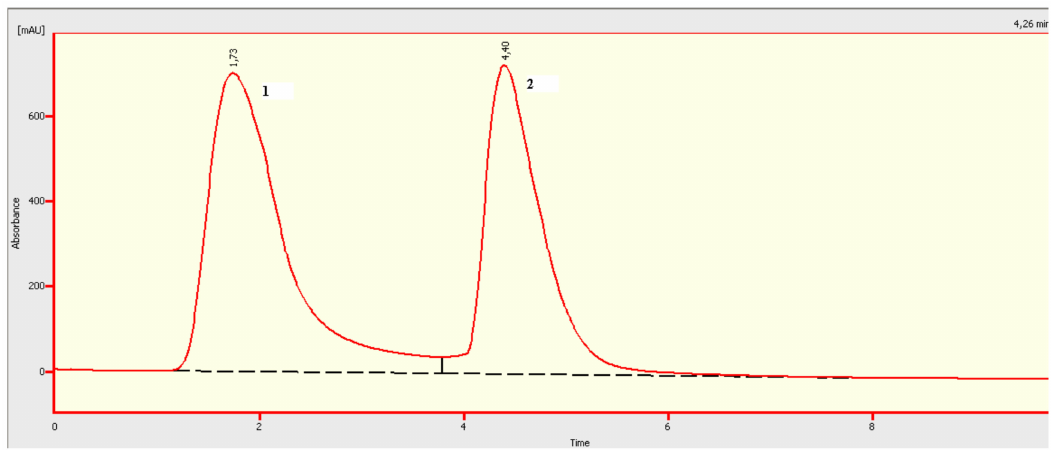
Figure 1. Chromatographic profile of separation of VP-VFA-VIDA (peak 1) and aquatedGa 3 + (peak 2); reaction time ≈ 2 min; detector wavelength: 220 nm.